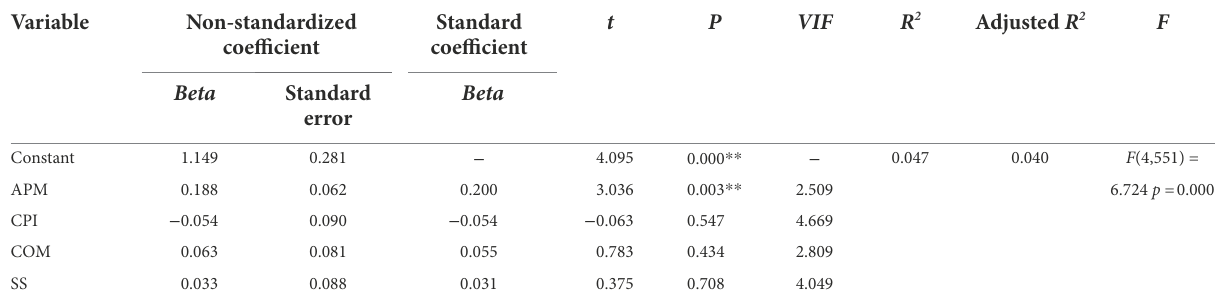
TABLE 10 Results of linear regression analysis.